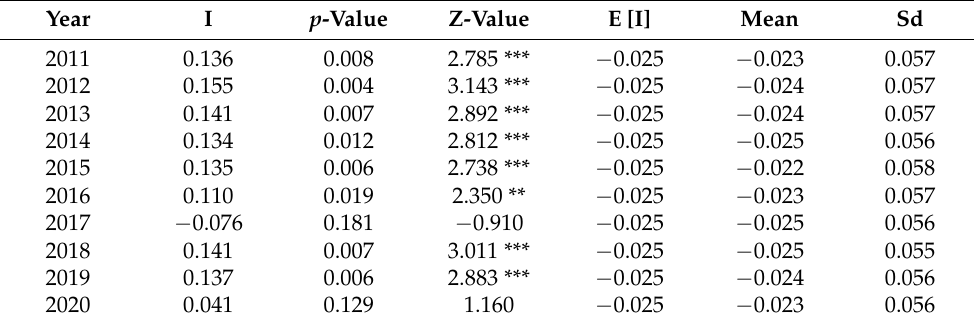
Table 3. Moran’s I index of contribution rate of GASTP from 2011 to